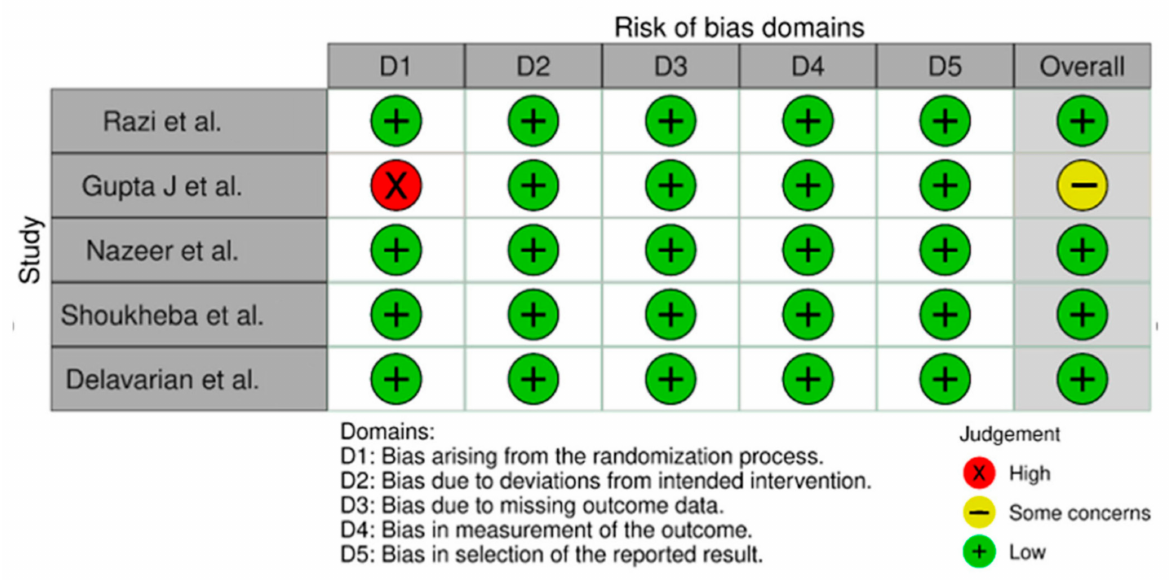
Figure 2. Illustrating the risk of bias domains